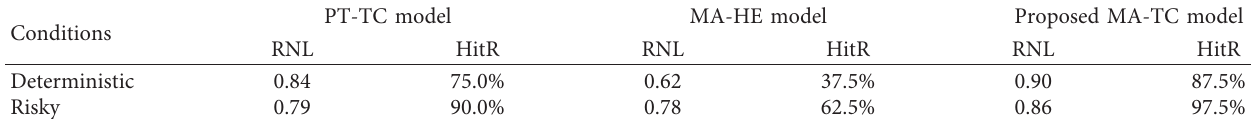
Table 6: Contrastive analysis of models.